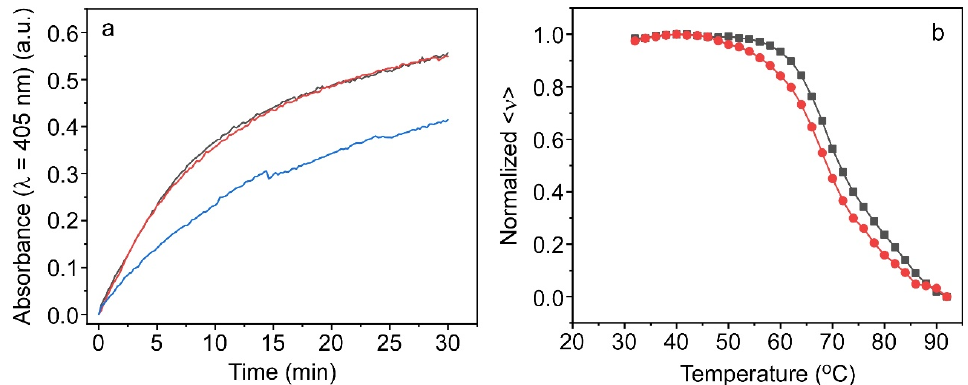
Figure 6. ( a ) Kinetics of PNP production by ALP@AETA freshly prepared xerogel (black), after a month (red) and after 18 months (blue) stored at room temperature. Samples were placed in quartz cuvettes of 1 cm path length and absorbance values were collected as a function of time at 405 nm. ( b ) Evolution of the mean fluorescence energy < ν > of ALP@AETA xerogels before (black squares) and after a month stored at room temperature (red circles).